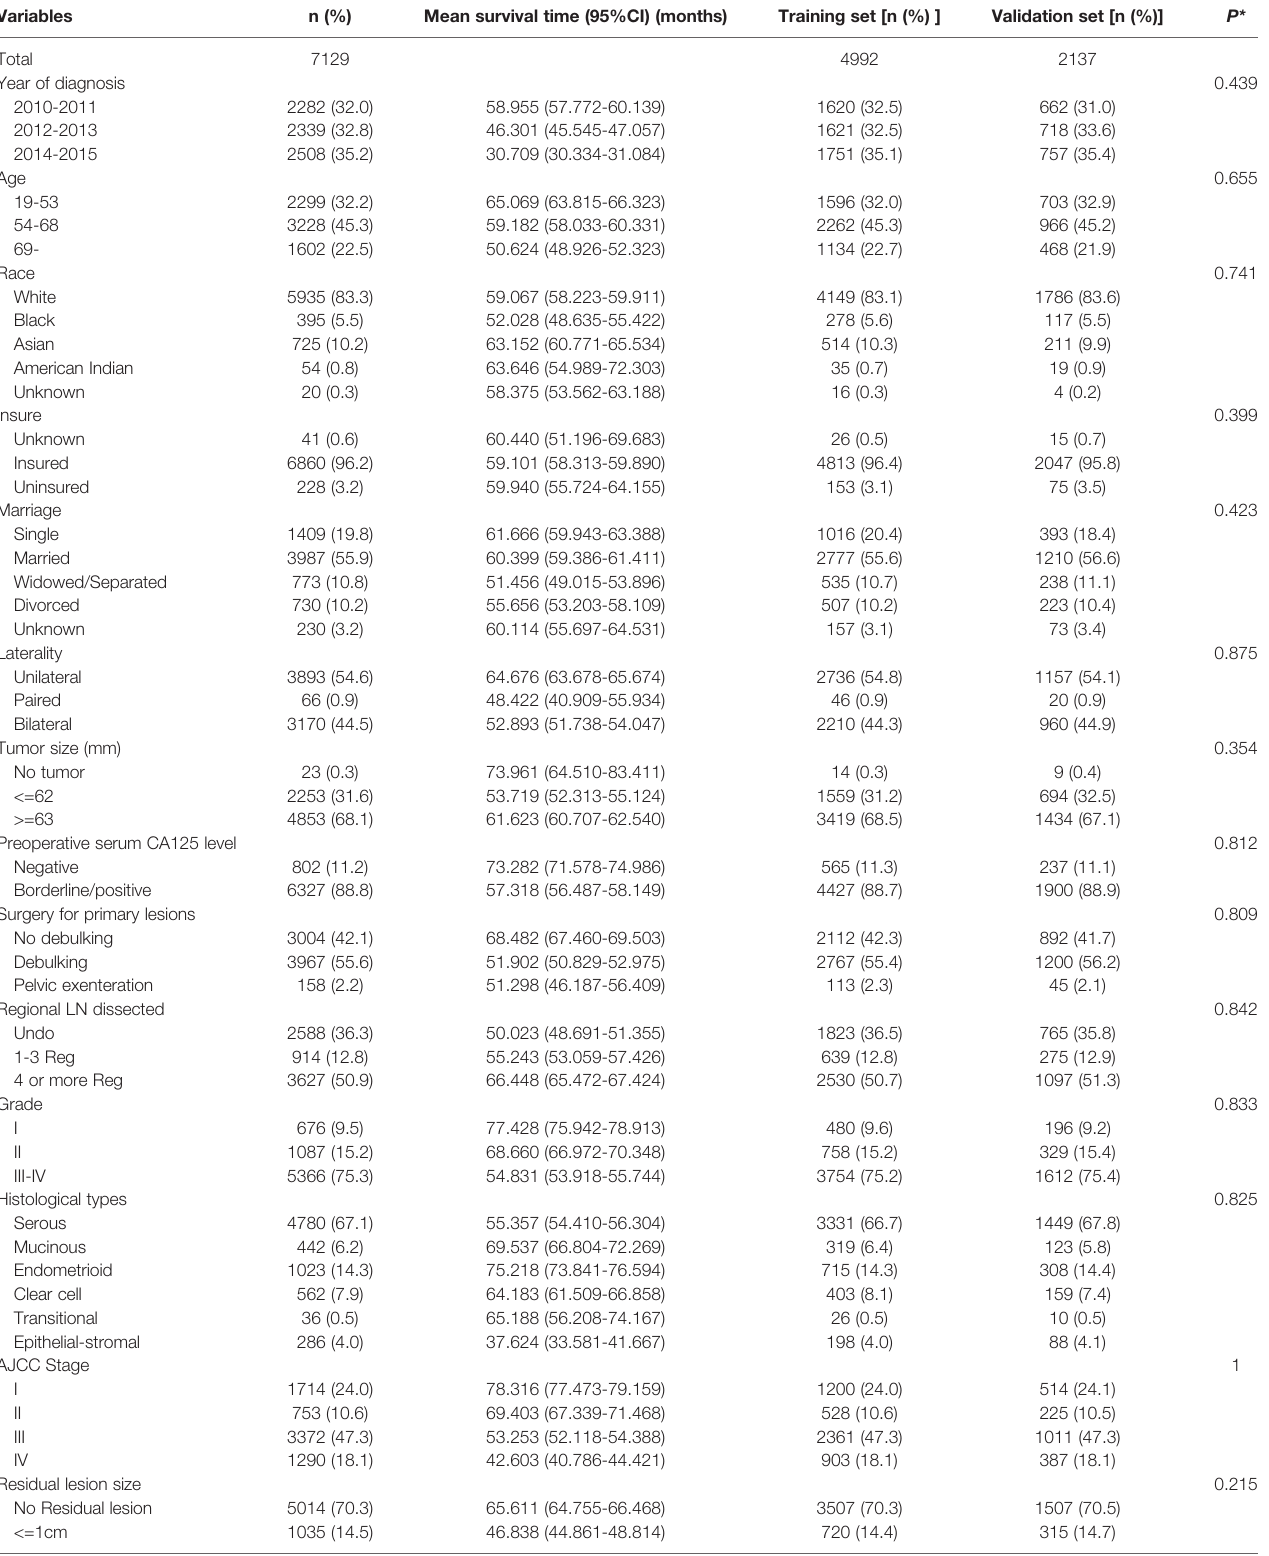
TABLE 1 | The clinicopathological characteristics and group comparison of 7129 patients with EOC.